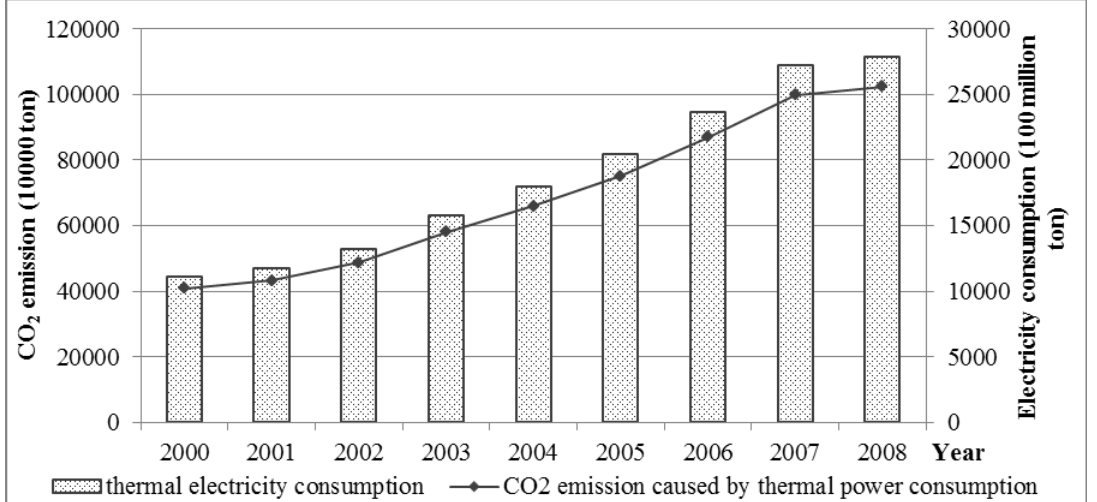
Figure 1. Electricity related CO